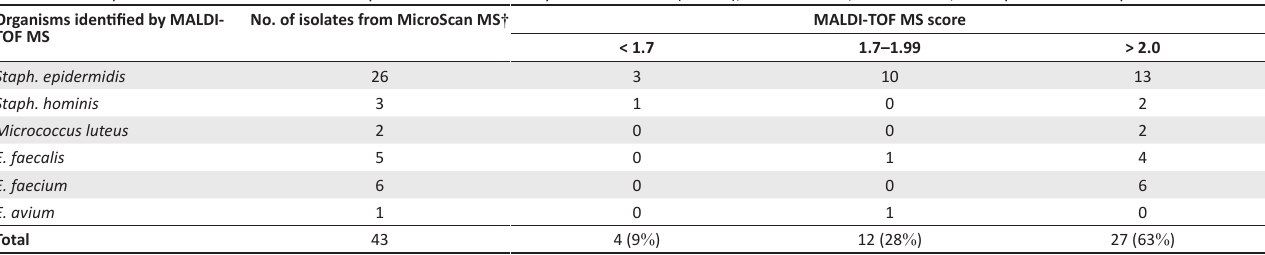
TABLE 5: Gram-positive bacteria identified directly from blood cultures by MALDI-TOF MS ( N = 43), Bloemfontein, South Africa, 15 July 2013 to 30 September 2013. Organisms identified by MALDI- TOF MS